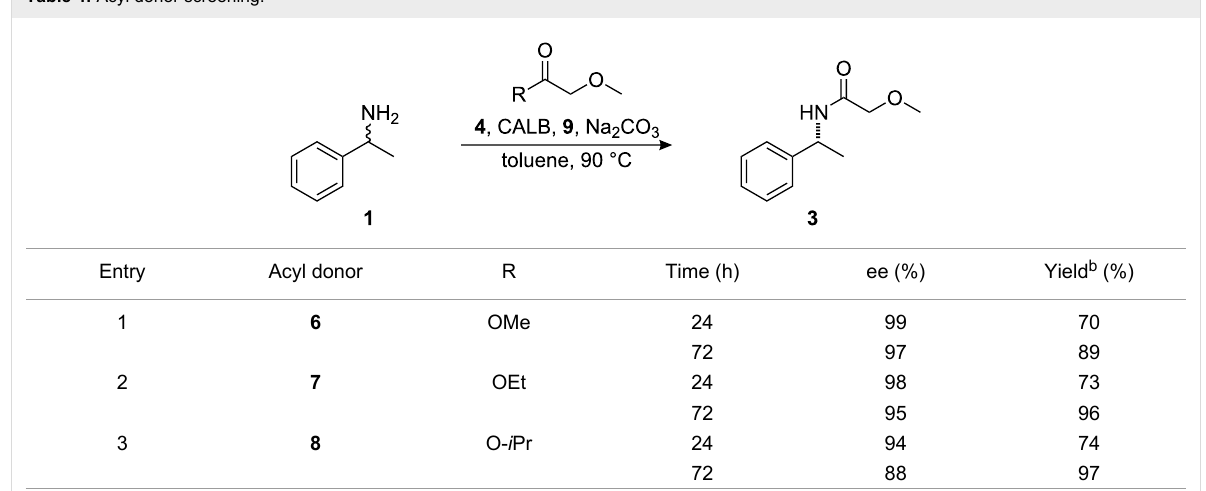
Table 4: Acyl donor screening. a